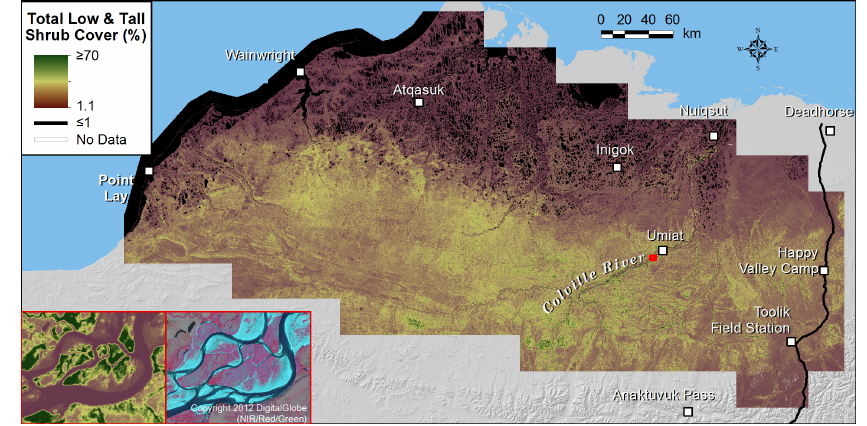
Figure 5. Map of total shrub cover based on the random forest model with 78 predictors, North Slope, Alaska. The inset map displays landscape-scale patterns in total shrub distribution in the upland terrain south of Umiat. Remote Sens. 2017 , 9 , 1024